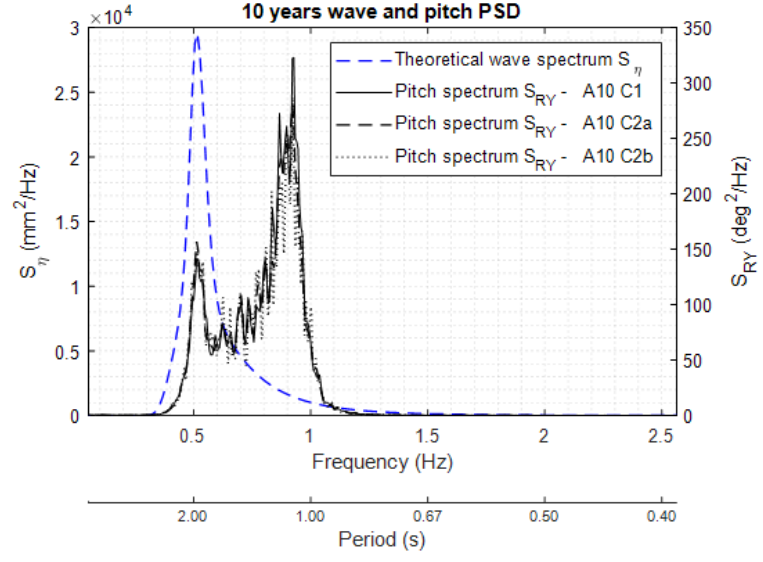
Figure 23. Pitch motion spectral density: 10-year